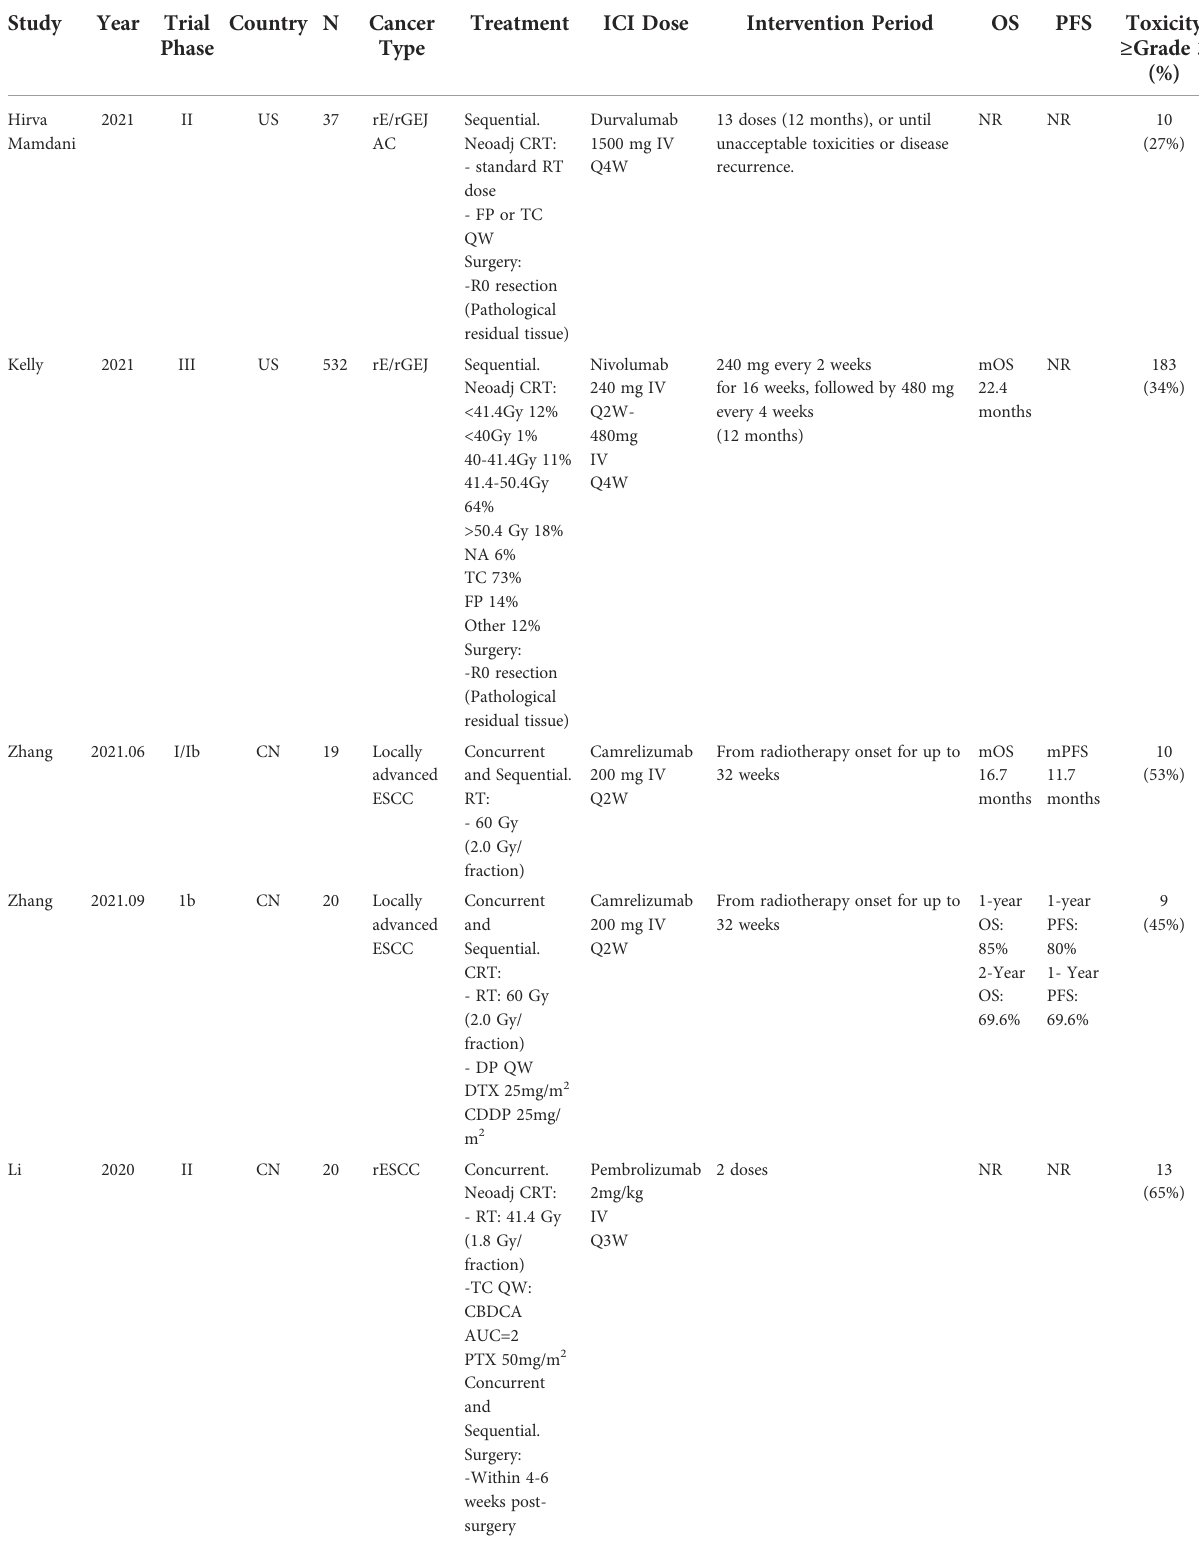
TABLE 1 Main characteristics of the selected